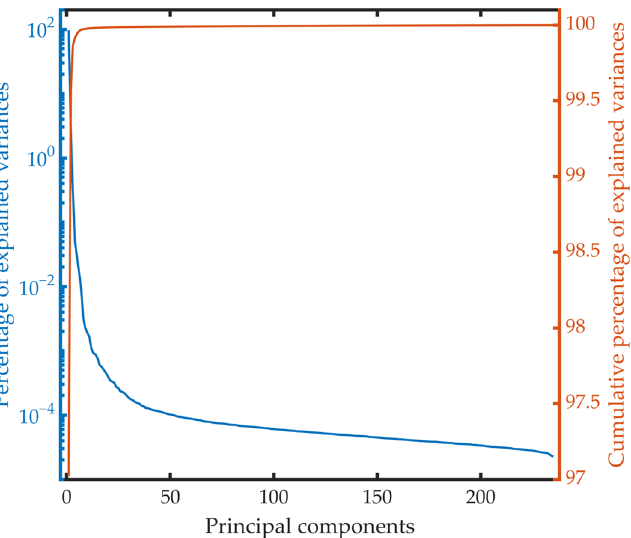
Figure 4. The percentage of explained variances of each principal component and the cumulative percentage of the explained variances. percentage of the explained